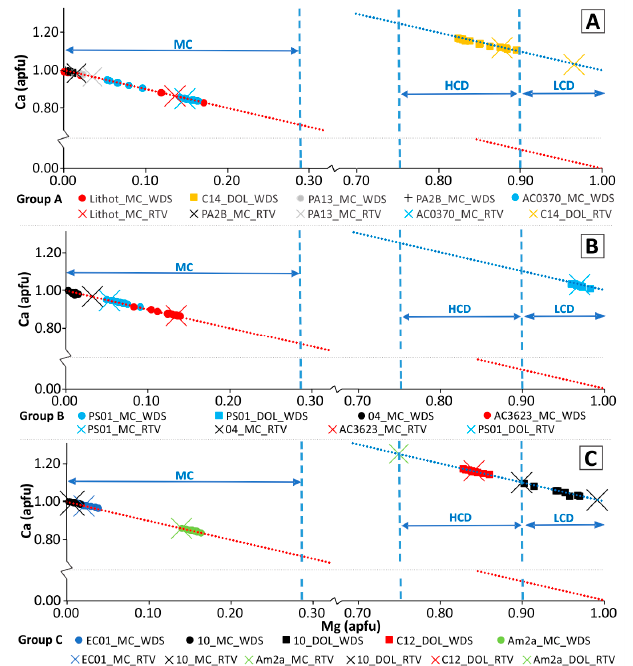
Figure 8. Results of EMPA (WDS) analyses represented by circles, triangles and diamonds, compared to the Rietveld (RTV) method represented by X for magnesian calcite (MC), dolomite I (LCD) and dolomite II (HCD). ( A – C ) Different groups of samples separated for clearer visualization. Data in Table S6.